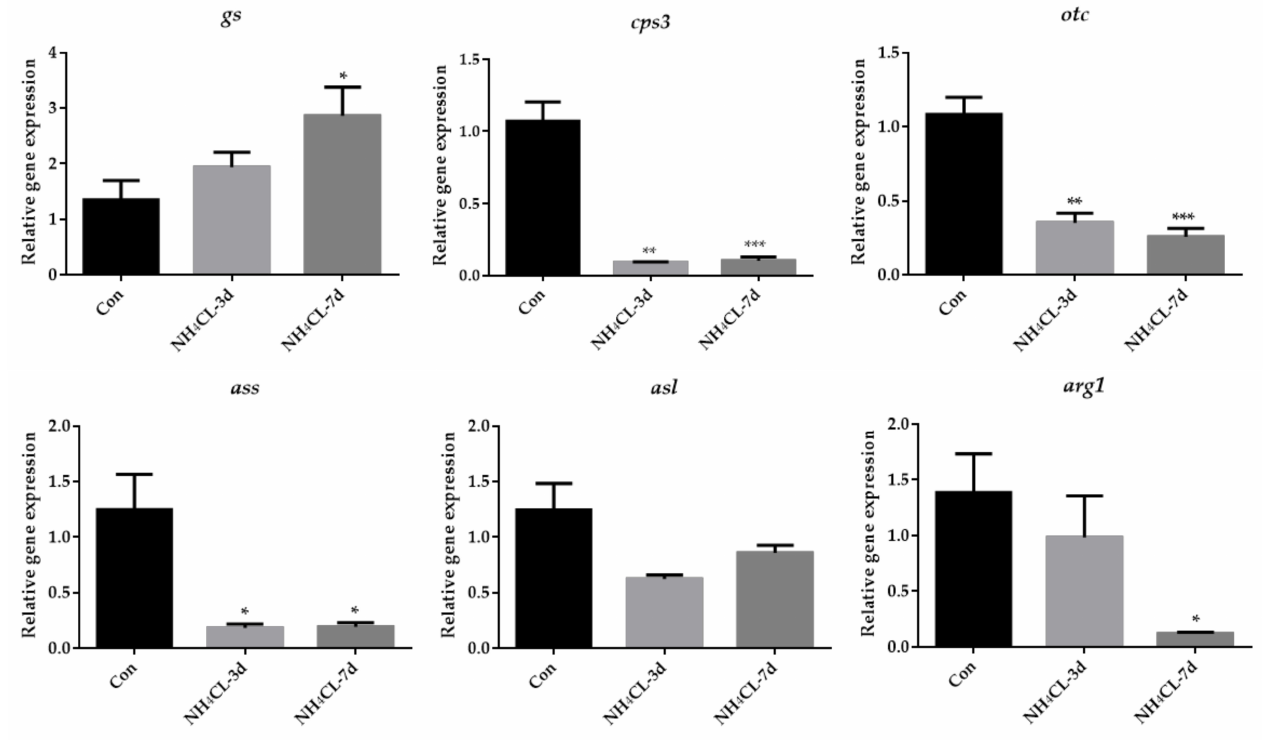
Figure 5. The expression of genes involved in the urea cycle ( gs , cps3 , otc , ass , asl, and arg1 ) in largemouth bass liver after ammonia exposure for 3 days and 7 days was affected. All data were analyzed with Student’s t -test and data were mean ± SEM ( n = 6). * p < 0.05; ** p < 0.01; *** p <